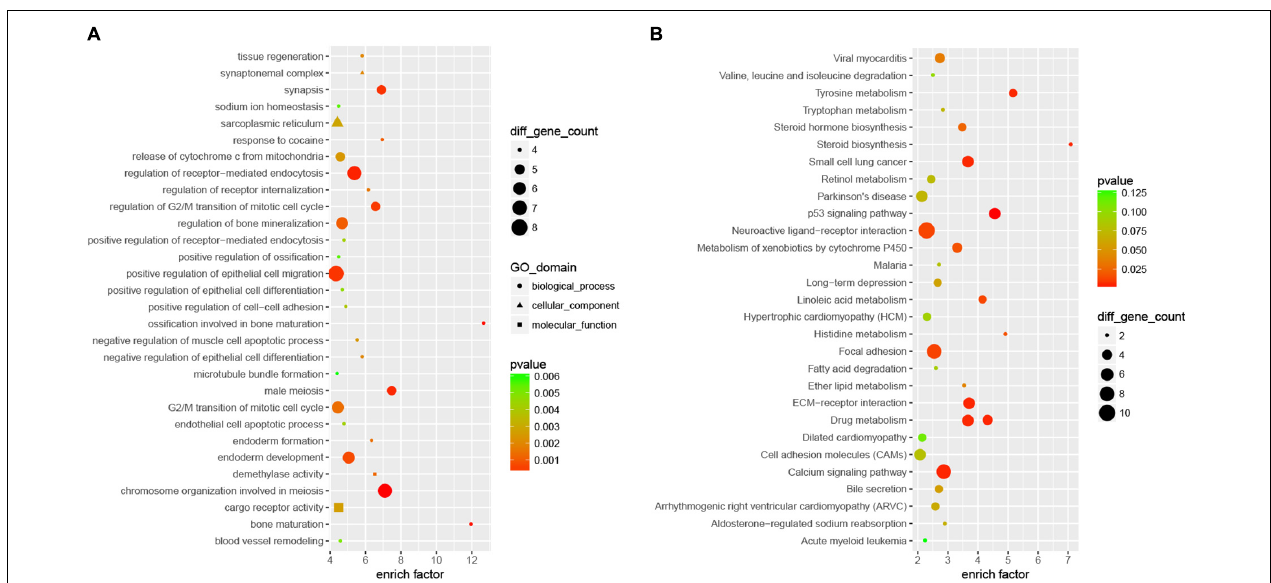
FIGURE 2 | The top 30 most significantly enriched GO (A) and KEGG (B) pathways of DEmRNAs between the Nrf2 (–/–) and Nrf2 (+/+) hippocampus. The x-axis shows counts of genes enriched in GO and KEGG pathways, and the y-axis shows the GO and KEGG pathways. The color scale depicts the p -value.